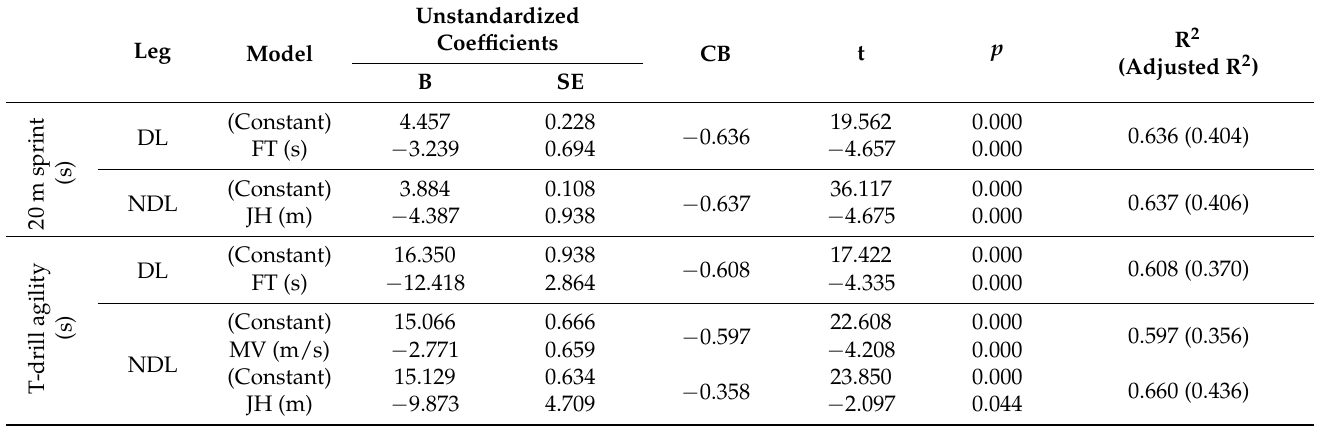
Table 4. Stepwise multiple regression analysis results of single-leg CMJ variables that influenced the 20 m sprint and T-drill agility scores for dominant and non-dominant legs.